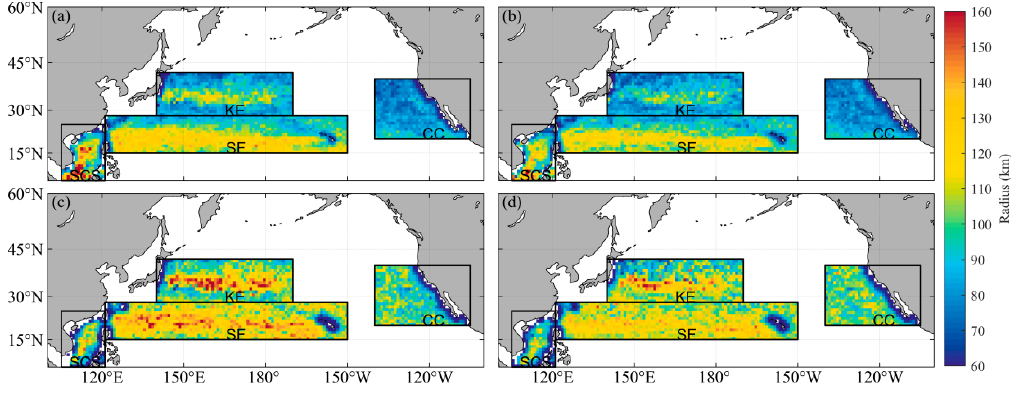
Figure 11. Same as Figure 9, but for eddy radii. Figure 11. Distribution of eddy radii. AEs and CEs detected by the META dataset are given in ( a ) and ( b ), respectively. Identically, AEs and CEs detected by the GOMEAD dataset are given in ( c ) and ( d ), respectively.